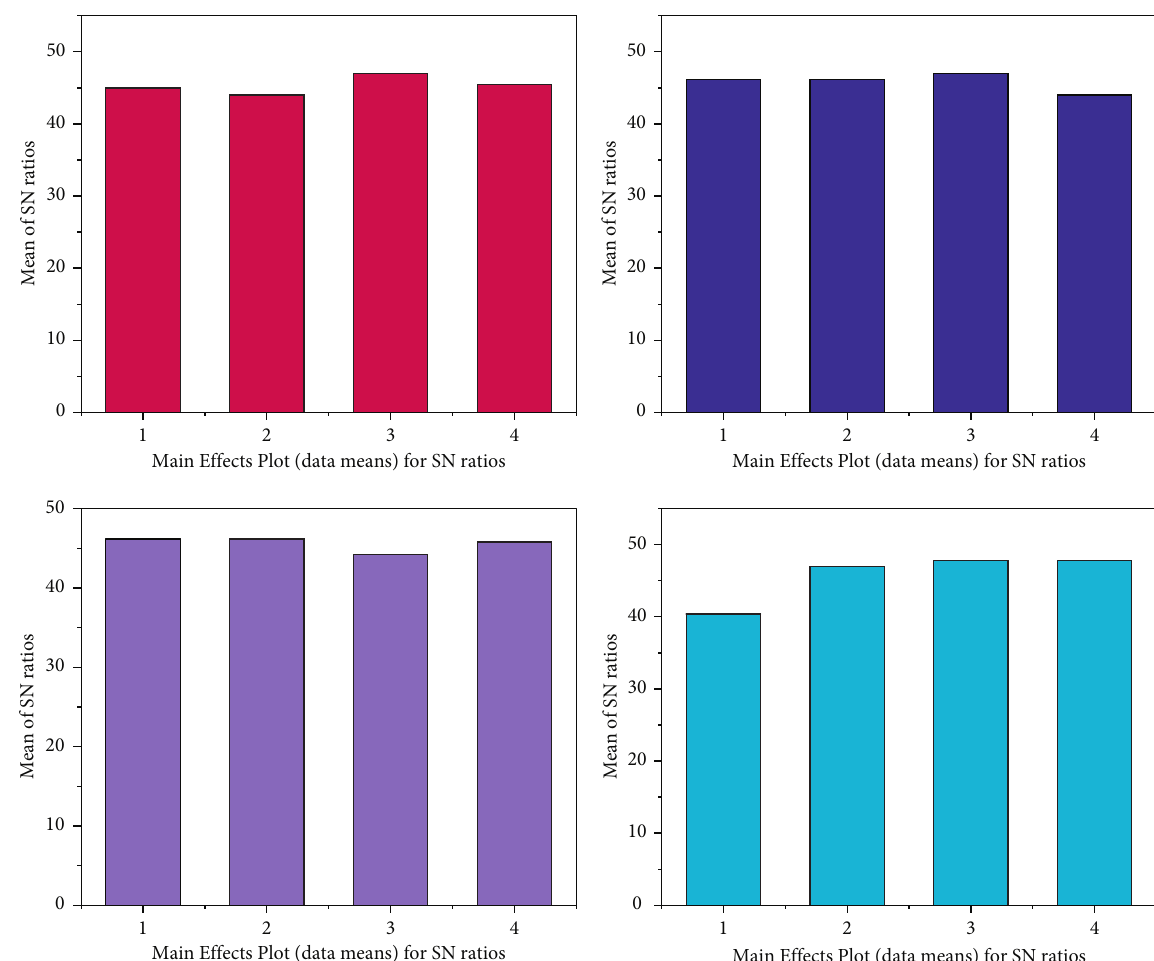
Figure 5: Main effects of the plot for SN